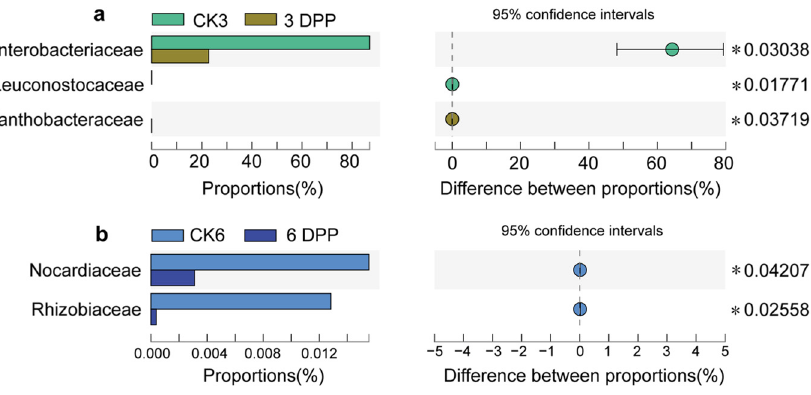
Figure 5. The difference in relative proportion (%) between parasitized and non-parasitized larvae at different sampling times at the family level. ( a ) CK3 vs. 3 DPP, ( b ) CK6 vs. 6 DPP. Statistical analysis was performed by the Wilcoxon rank-sum test. The symbol * indicates p < 0.05.